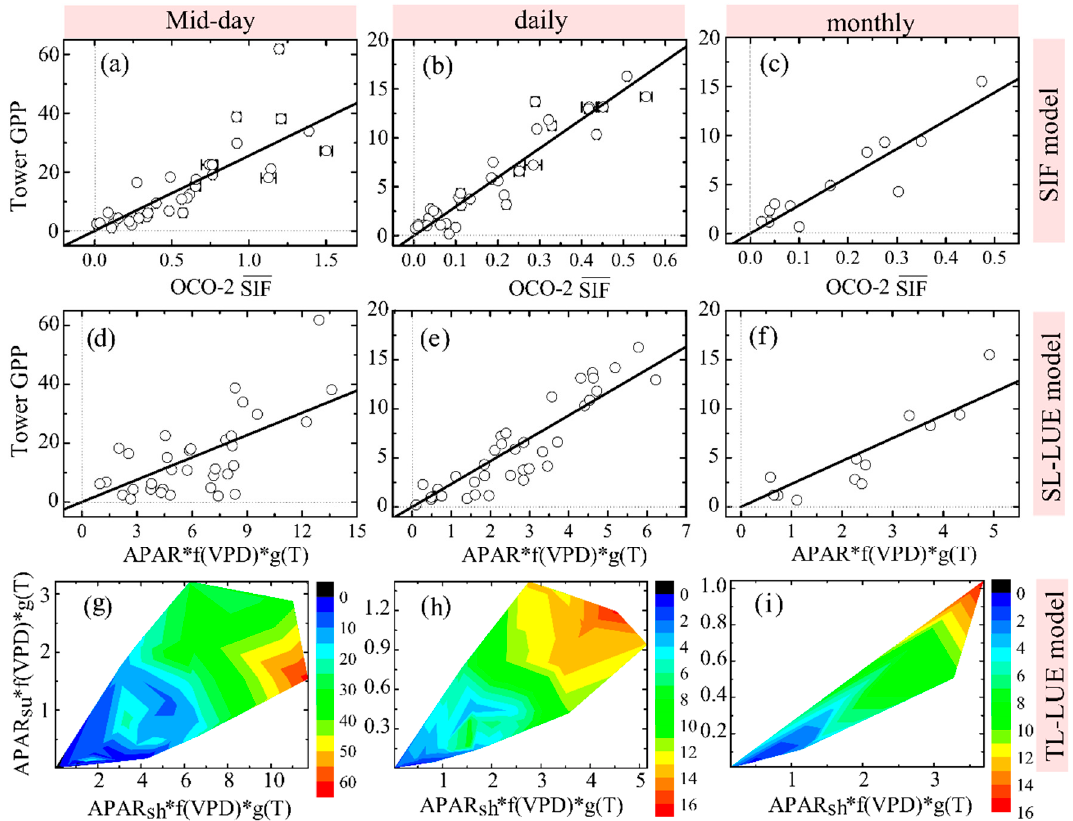
Figure 3. Fitting results of parameters for di ff erent models on di ff erent timescales in 2015. The columns from left to right show the mid-day, daily, and monthly timescales, respectively. The rows from top to bottom indicate the SIF model ( GPP ≈ ε / SIF yield × SIF ), the one-leaf light-use e ffi ciency (SL-LUE) model ( GPP = ε max × APAR × f ( VPD ) × g ( T a ) ), and the two-leaf LUE (TL-LUE) model ( GPP = ε msu × APAR su × f ( VPD ) × g ( T a ) + ε msh × APAR sh × f ( VPD ) × g ( T a ) ), respectively. There are 39 data points for mid-day and daily time scales and 12 data points for monthly time scale. The unit of tower GPP is gC m − 2 day − 1 , the unit of OCO-2 SIF is W m − 2 µ m − 1 sr − 1 , and the unit of APAR × f(VPD) × g(T) is MJ m − 2 day − 1 (1 MJ = 10 6 J). Table 2. The posterior estimations of ε / SIF yield (gC m − 2 day − 1 (W m − 2 µ m − 1 sr − 1 ) − 1 ) in the SIF model, ε max (gC MJ − 1 ) in the SL-LUE model, ε (gC MJ − 1 ) and ε (gC MJ − 1 ) in the TL-LUE model, and the coefficient of variation (CV, equal to 100% × standard deviation divided by the mean) of these optimizing parameters from mid-day to monthly timescales in 2015. All correlations were statistically significant ( p < 0.001).